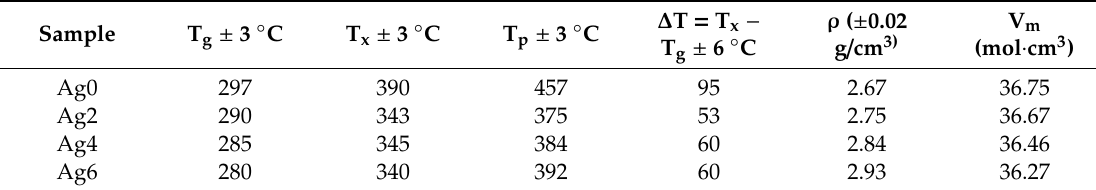
Table 1. Thermal properties and density of the glasses.